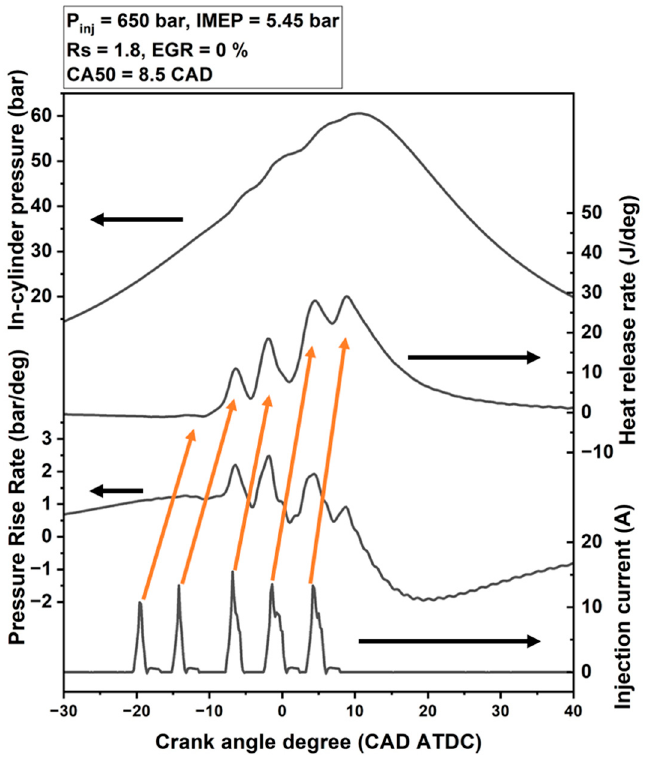
Figure 4. The in-cylinder pressure, heat release rate, pressure rise rate, and injection current of the MSS injection. MSS